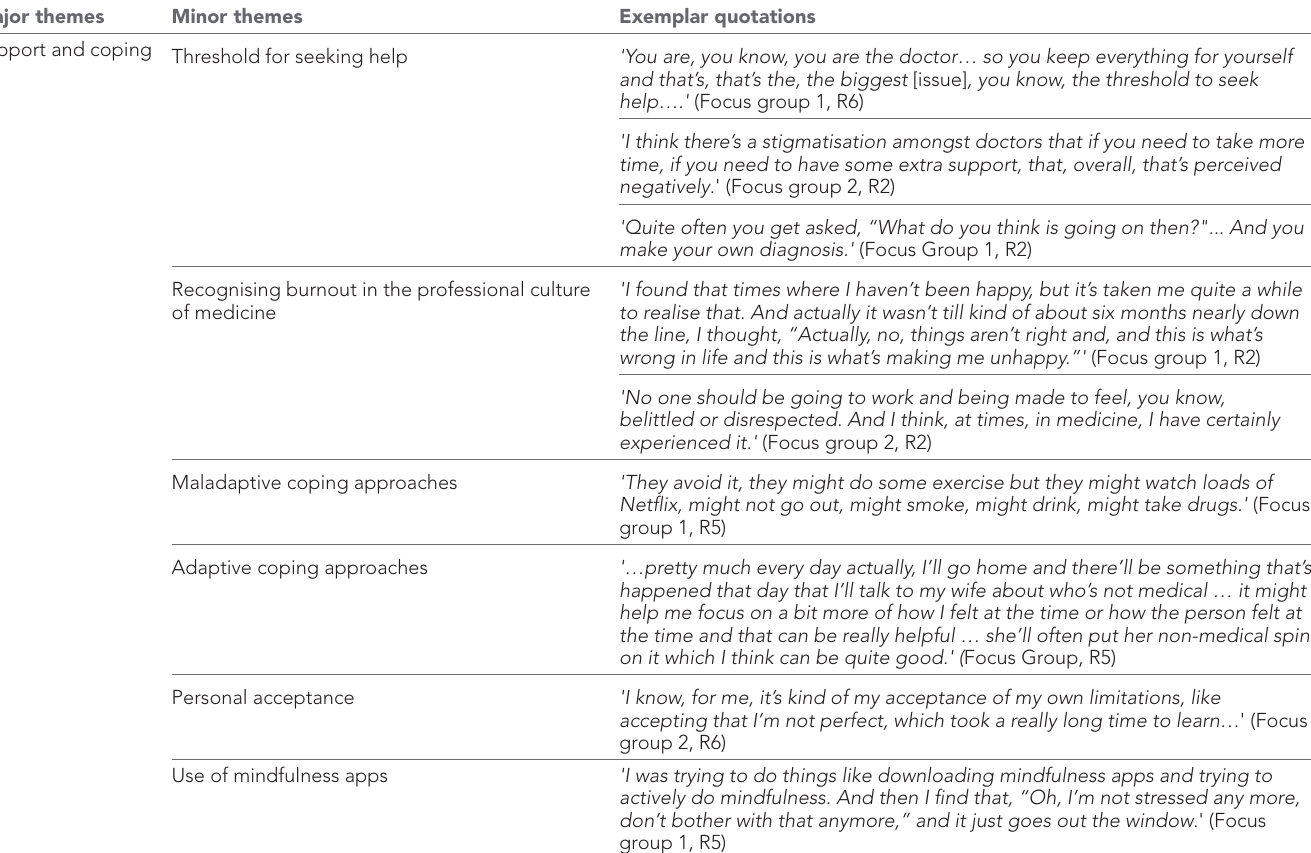
Table 4 Exemplar quotations from participants: support and coping